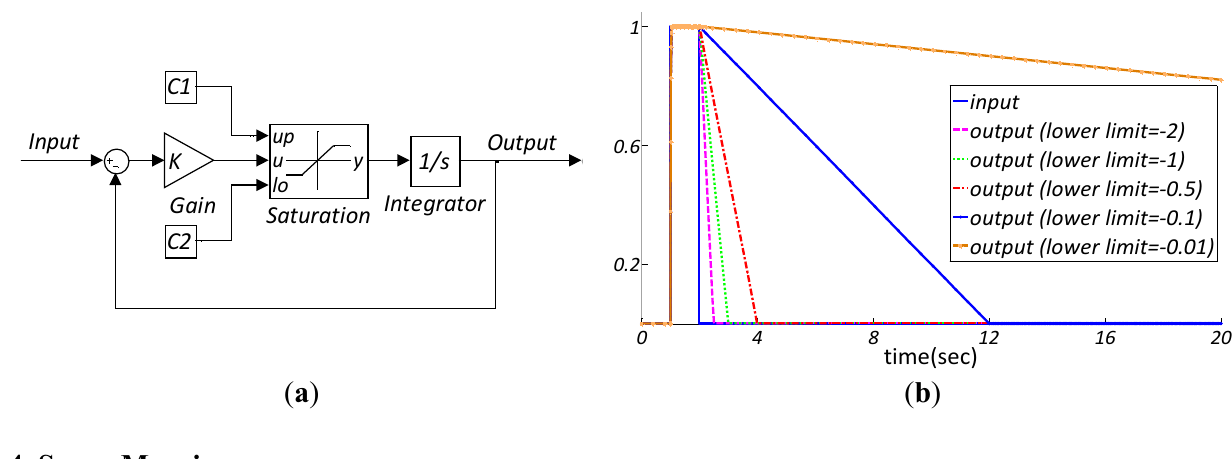
Figure 4. ( a ) Hold function; and ( b ) the response of the hold function to a sample function (gain = 100, upper limit =